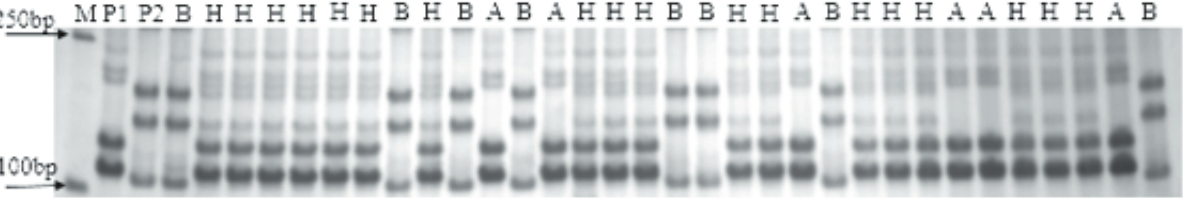
Figure 2. Amplification results with primer Xgwm291 in parents and the F 2 population. M: DL2000 marker; P1: SN051-2; P2: SN051-1; B: F 2 individuals with long awn in; H: F 2 individuals with a short